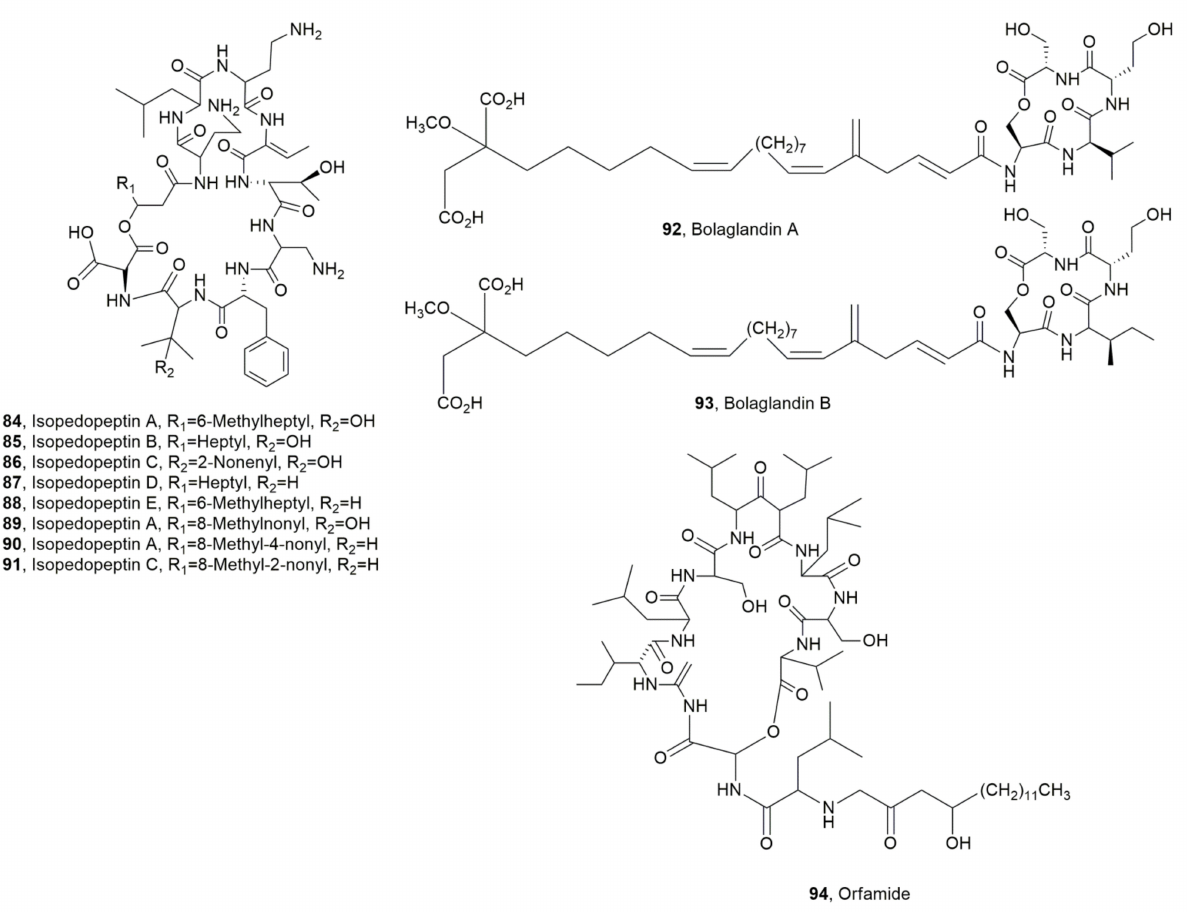
Figure 10. Structure of lipodepsipeptides produced by Pedobacter cryoconitis ( 84 – 91 ), by Burkholderia gladioli ( 92 and 93 ), and by Pedobacter protegens ( 94